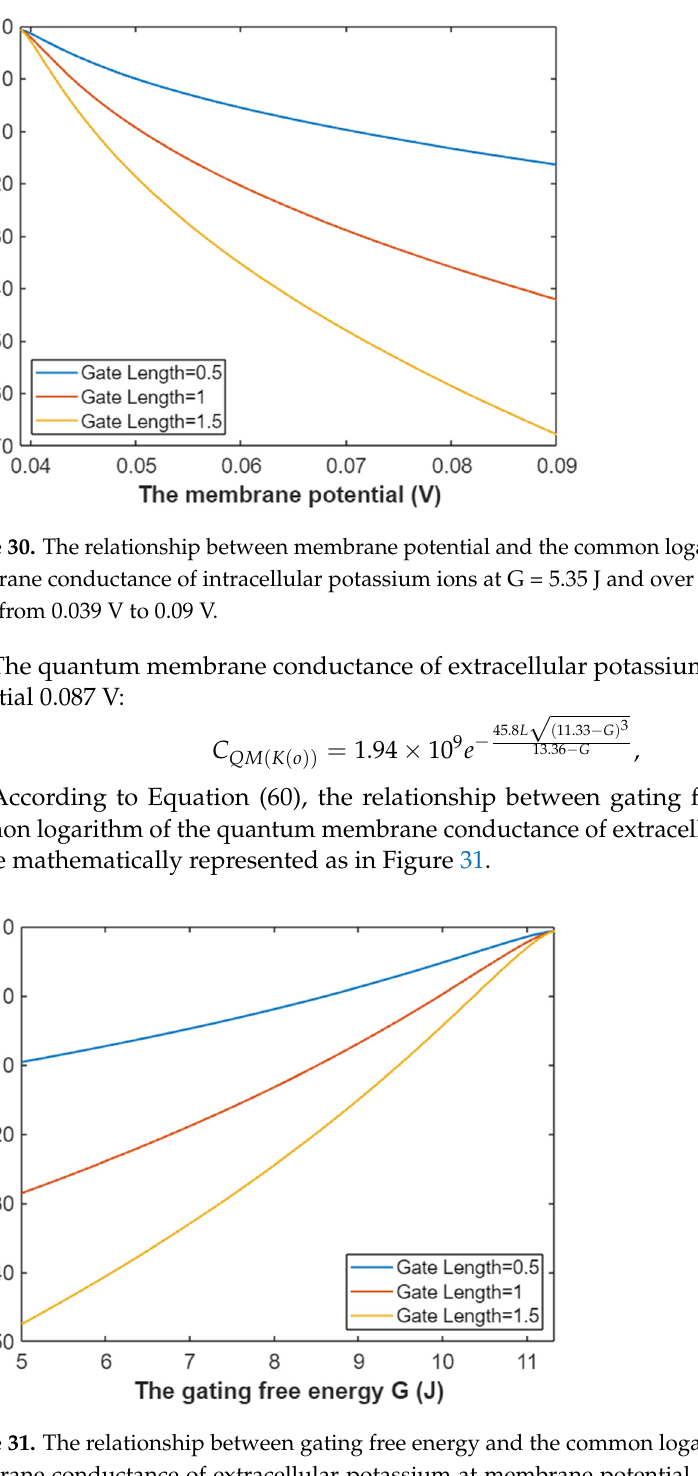
Figure 32. The relationship between gating free energy and the common logarithm of the quantum membrane conductance of intracellular potassium ions at membrane potential of 0.087 V and over a gating free energy range from 5 J and 12.72 J.